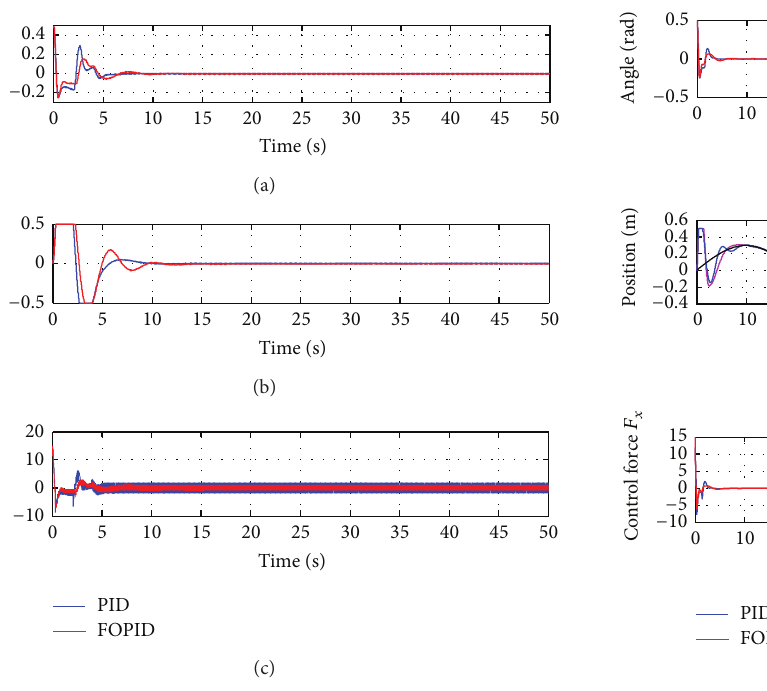
Figure 7: Stabilization of inverted pendulum (with disturbances = 𝑑 = 20 sin (20𝜋𝑡) ). 𝑑 1 2